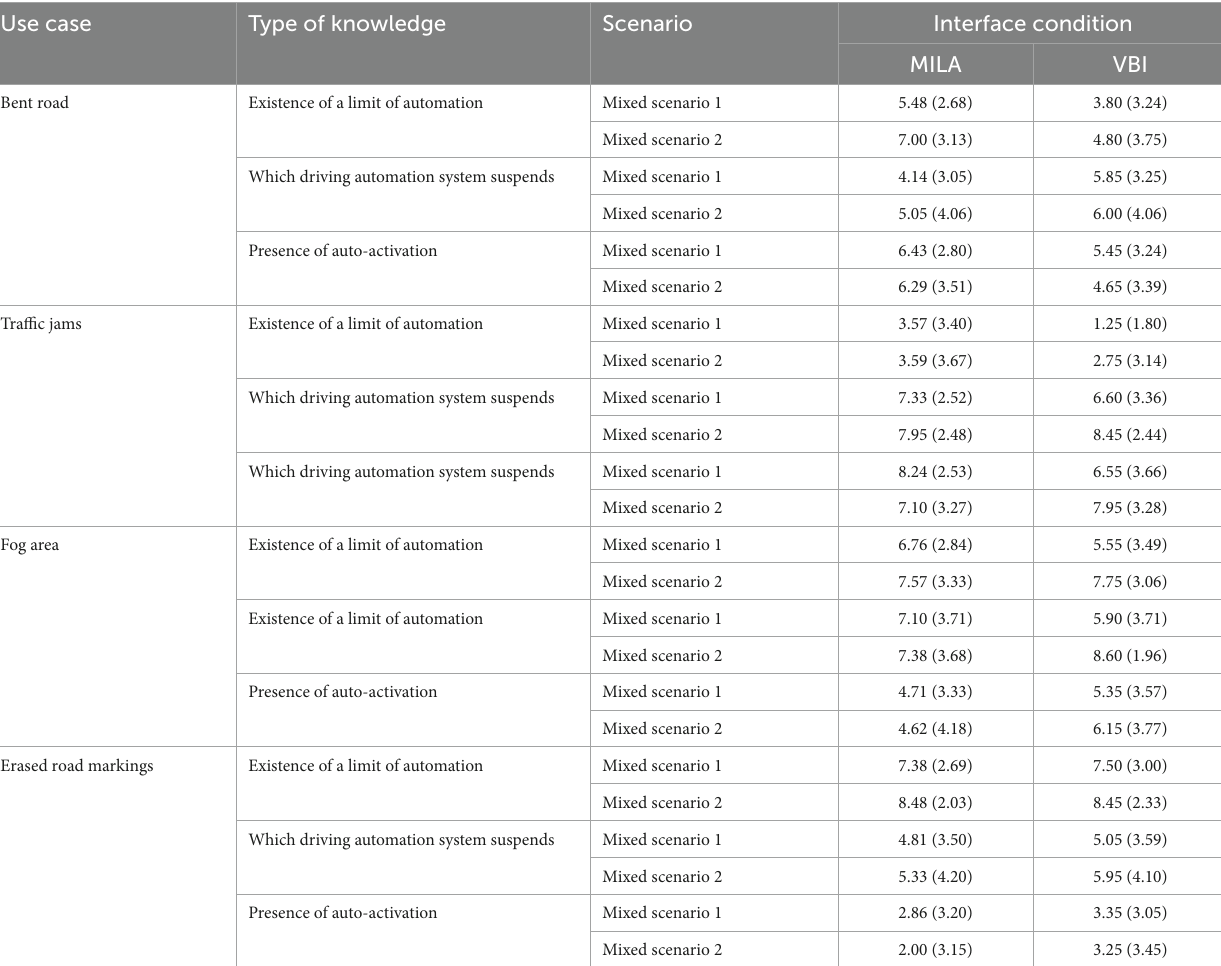
TABLE 6 Descriptive statistics [mean (SD)] of the scores1 to the mental model rating scales depending on the use case, type of knowledge investigated by the question, scenario, and interface condition. Use